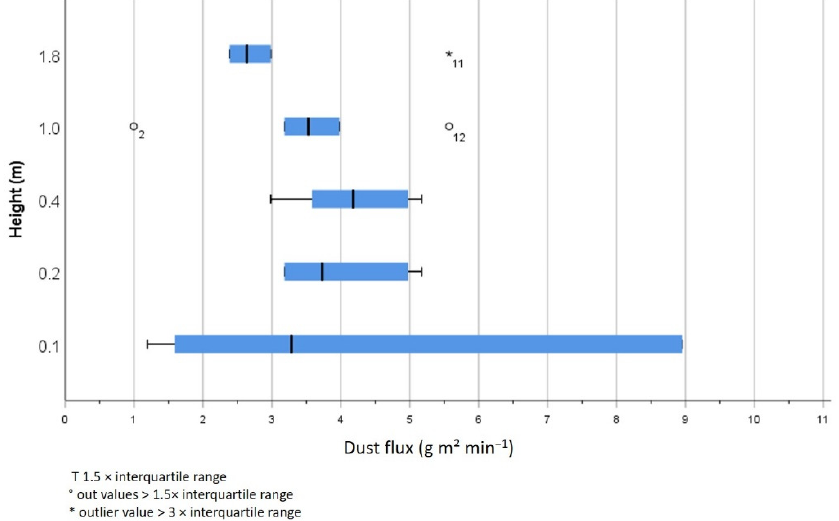
Figure 10. Vertical distribution of collected material from masts (median) .